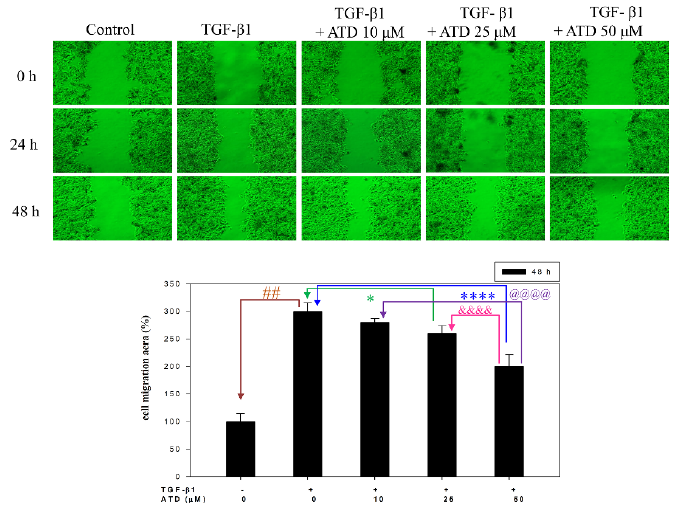
Figure 3. Effect of ATD on TGF- β 1-induced migration of HepG2 hepatoblastoma cells by wound-healing assay. Cells were cultured in 6-well plates and pretreated with or without (control group) 10 ng/mL of TGF- β 1 for 24 h. A wound was scratched by a 200 μ L pipette tip. After washing with PBS, cultured medium was replaced with fresh medium and with or without coadministration of TGF- β 1 and ATD (0, 10, 25, or 50 μ M) for 24 h and 48 h, then photographed at 0 h, 24 h, and 48 h. Migration activity of cotreated with TGF- β 1 and ATD for 48 h was quantified with ImageJ software. Data are represented as the mean ± SD from three independent experiments. ##: TGF- β 1 vs. control, p < 0.01; *: TGF- β 1 vs. TGF- β 1+ 25 μ M ATD, p < 0.05; ****: TGF- β 1 vs. TGF- β 1+ 50 μ M ATD, p < 0.0001; &&&&: TGF- β 1+ 25 μ M ATD vs. TGF- β 1+ 50 μ M ATD, p < 0.0001; @@@@: TGF- β 1+ 10 μ M ATD vs. TGF- β 1+ 50 μ M ATD, p < 0.0001.